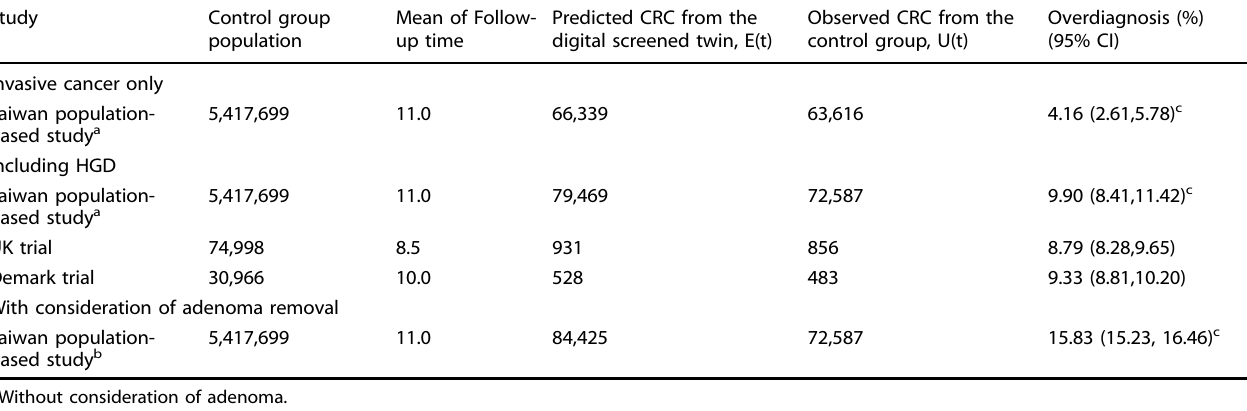
Table 2. Estimated the proportion of overdiagnosis based on overdiagnosis-embedded disease natural history model in three studies.